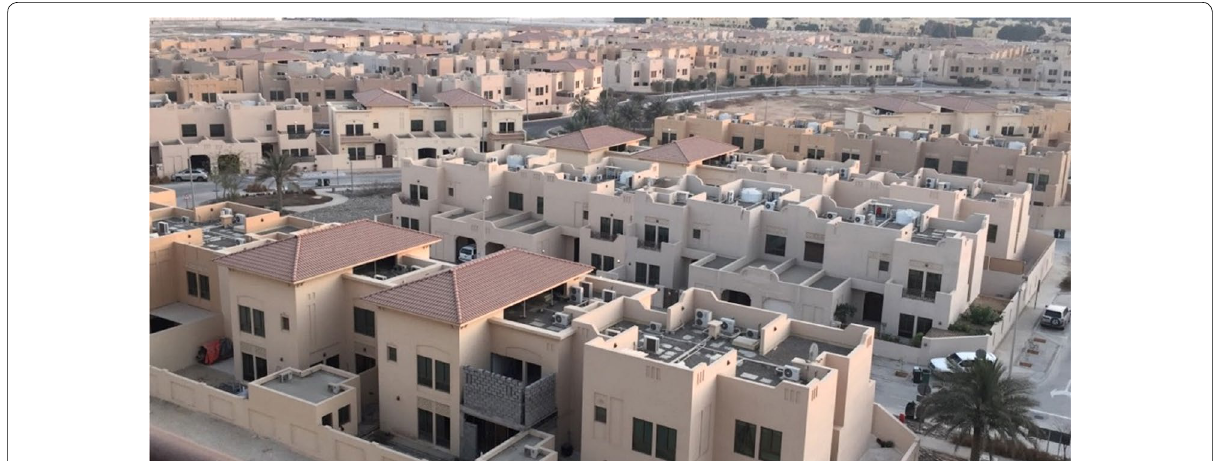
Fig. 4 The Al Watani district of the UAE public housing fund